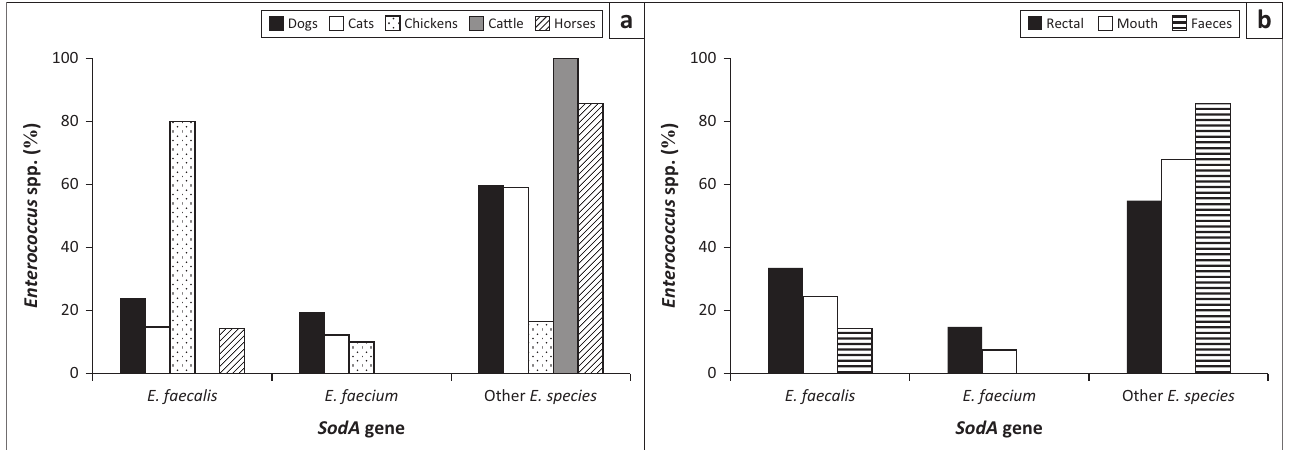
FIGURE 2: (a) Species within animal sources and (b) species within site of collection – prevalence of Enterococcus spp. detected in each animal species and within each site of collection.